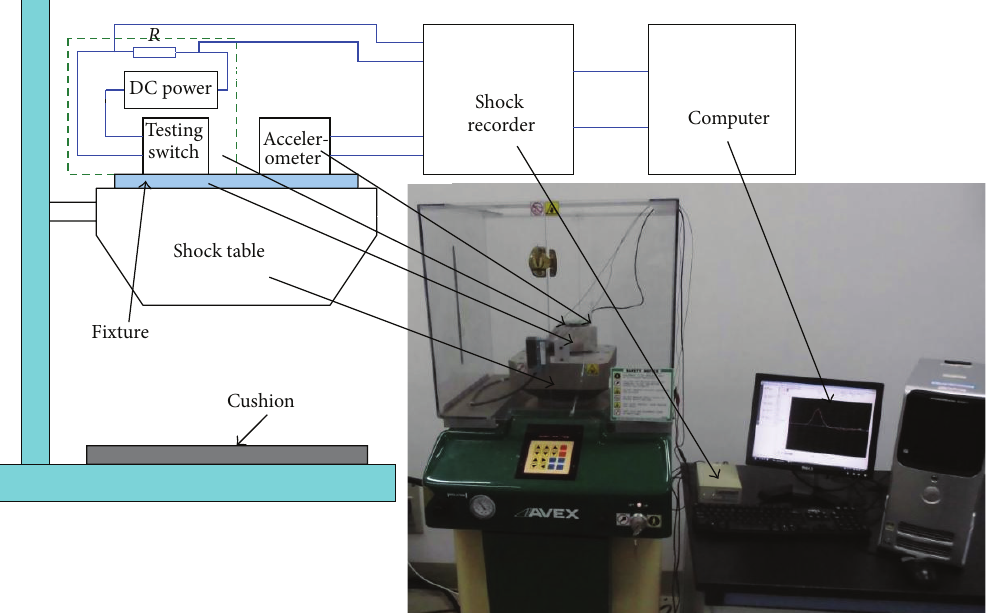
Figure 10: Shock test devices for the switch